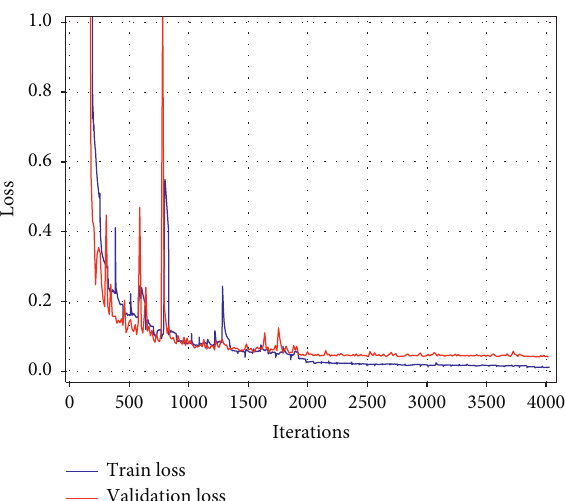
Figure 6: Average losses in training and validation from DSCNN-VO loss function over iterations.